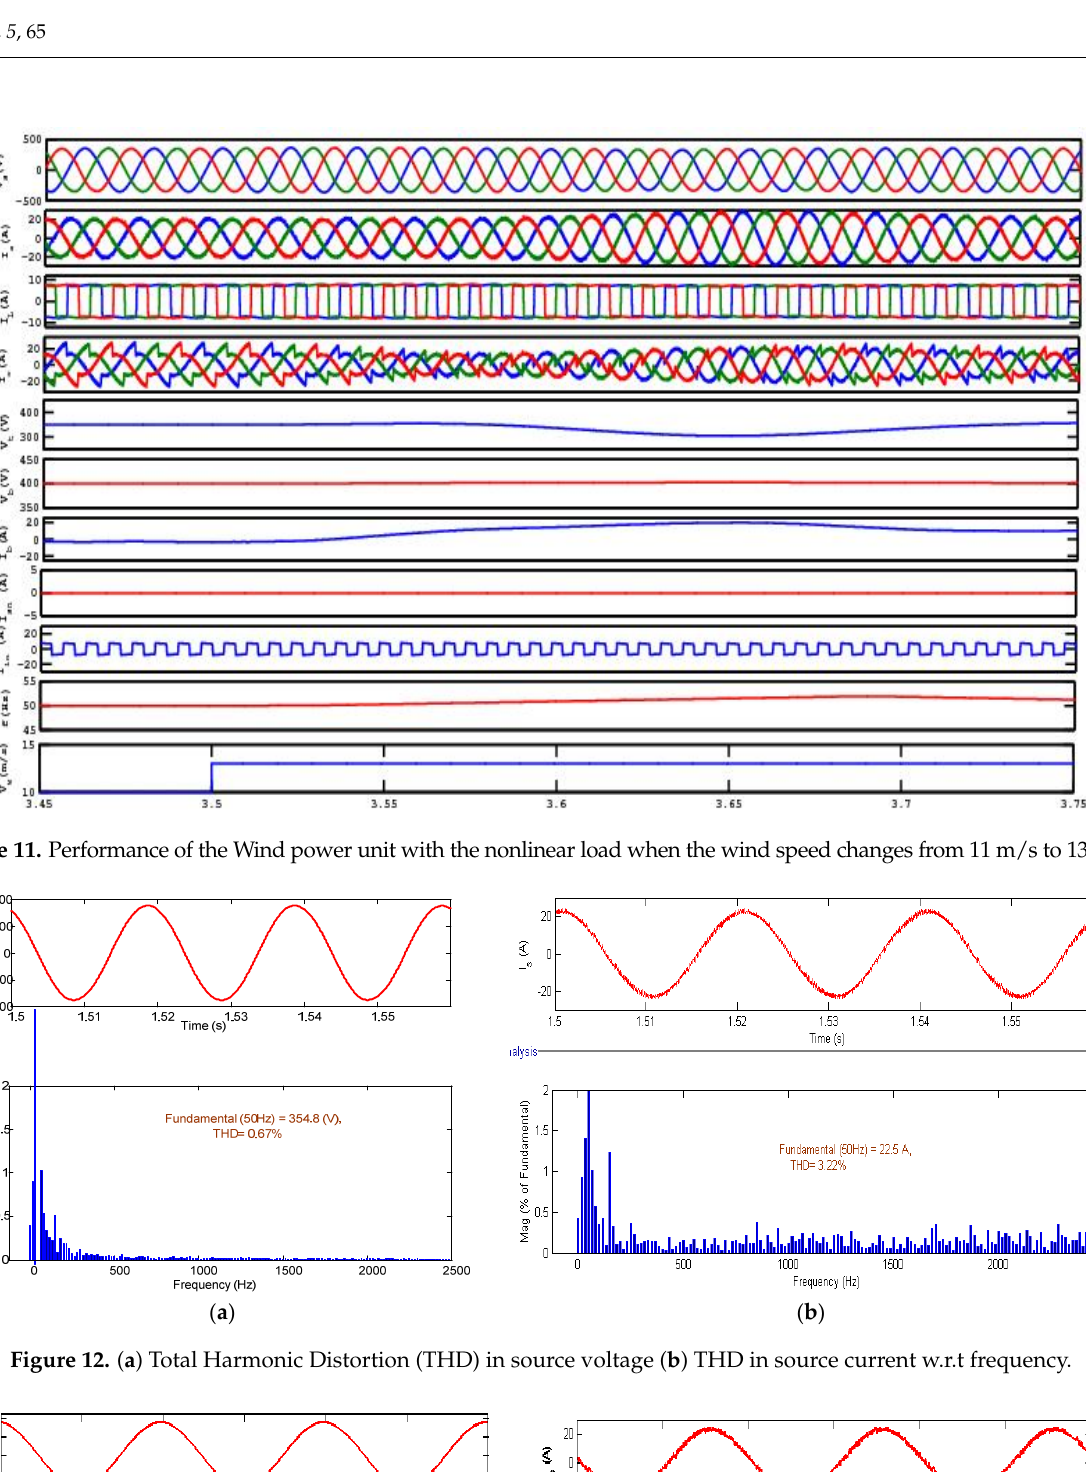
Figure 10. Performance of the Wind power unit with nonlinear load when the wind speed changes from 11 m/s to 13 m/s. Figure 11 shows the effect of wind speed change in the operation of the wind power unit when it supplies to a nonlinear load.